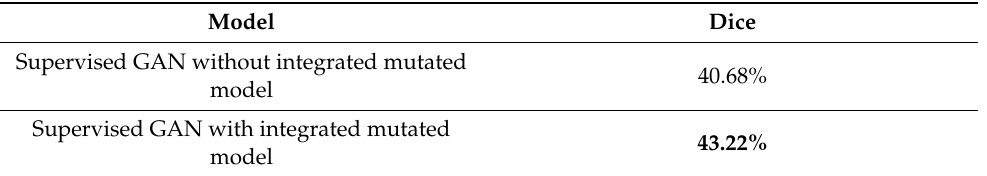
proposed supervised GAN model. The valid set of the ISLES-2018 dataset is used for